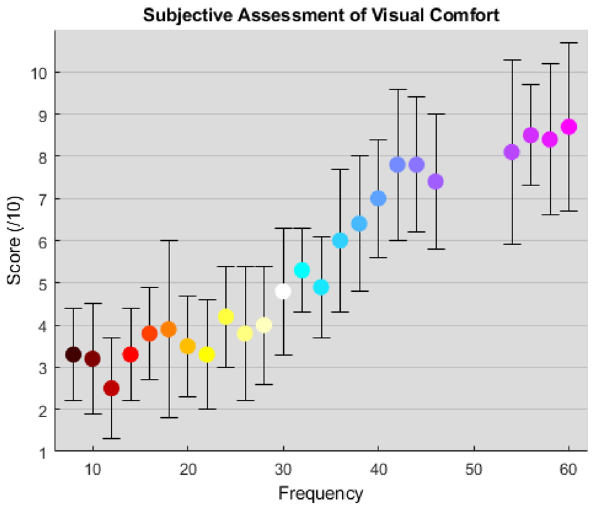
Figure 1. Experiment 1: relationship between RVS frequency (ranging from 8 to 60 Hz with a step increase of 2 Hz at the exclusion of 48 to 52 Hz) and the subjective visual comfort